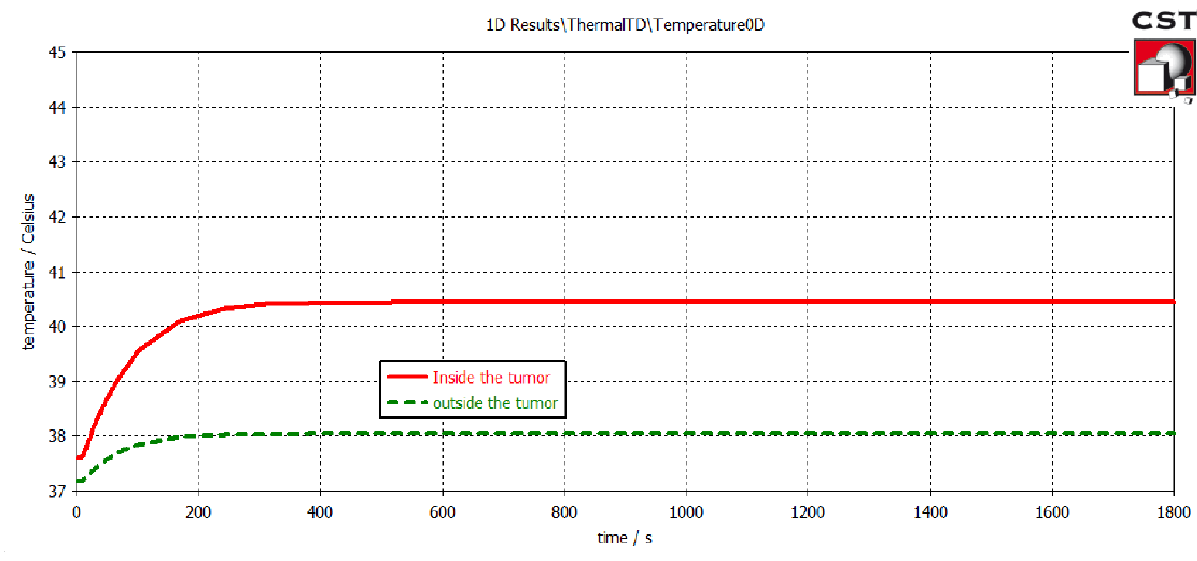
Figure 12: Temperature distribution during hyperthermia with AgNPs at 915 MHz